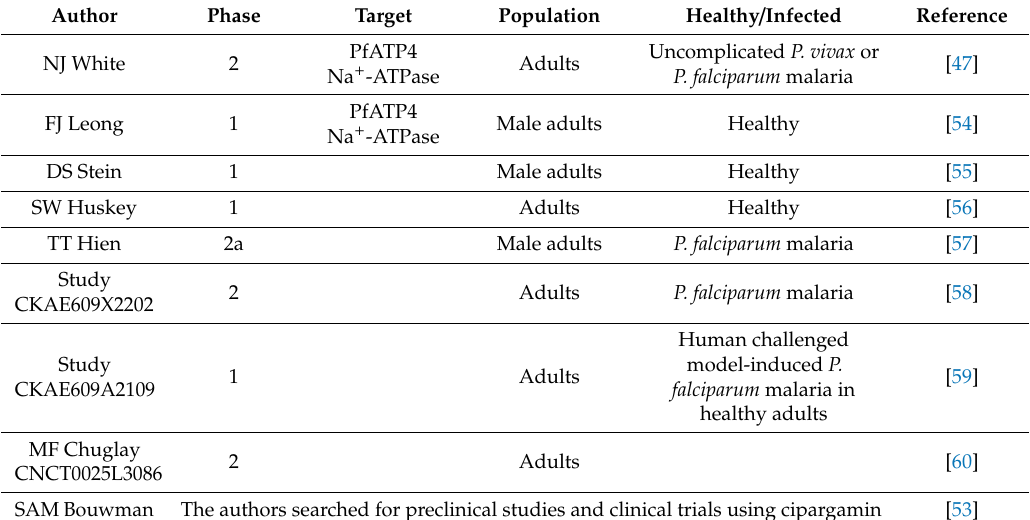
Table 1. Clinical trials on